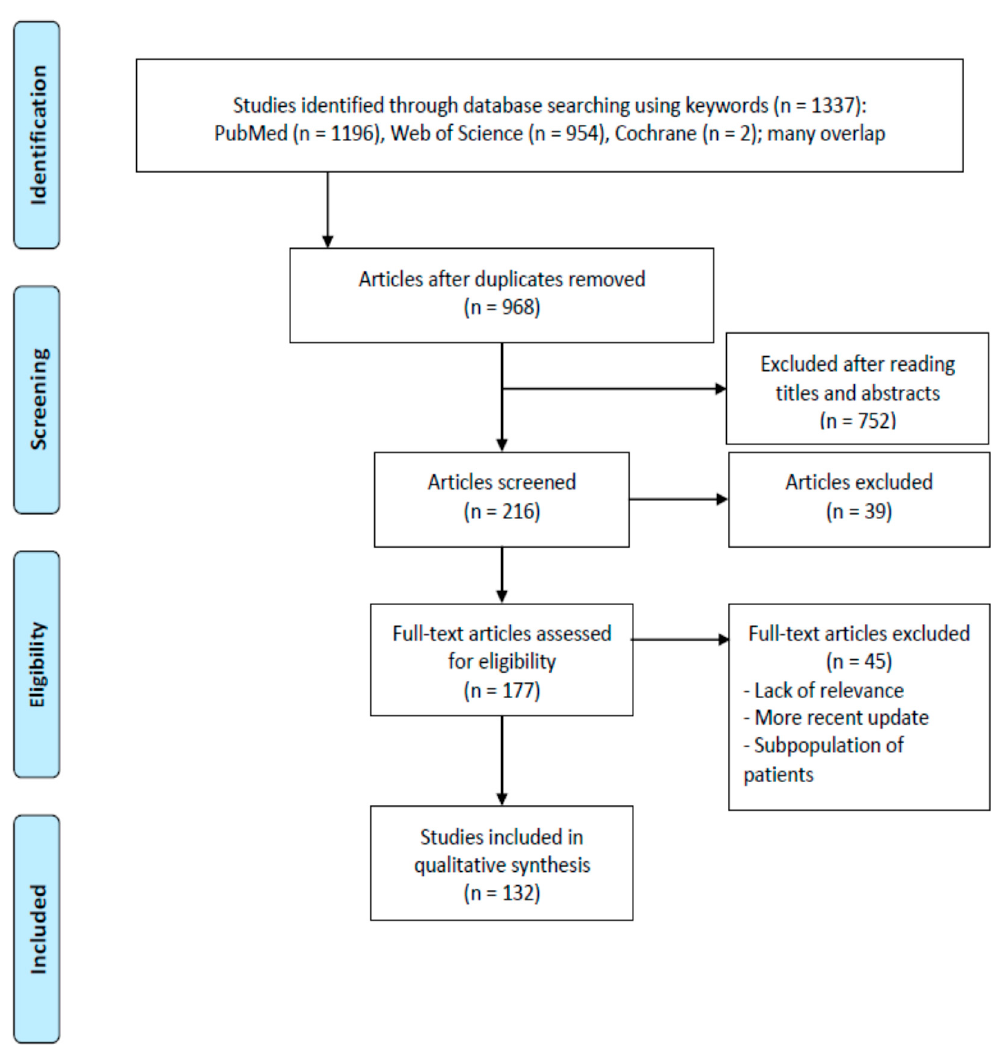
Figure 1. PRISMA 2009 flow diagram illustrating the selection process for the articles included in this review [15]. PRISMA documents are distributed under the terms of the Creative Commons Attribution License, which permits unrestricted use, distribution and reproduction.